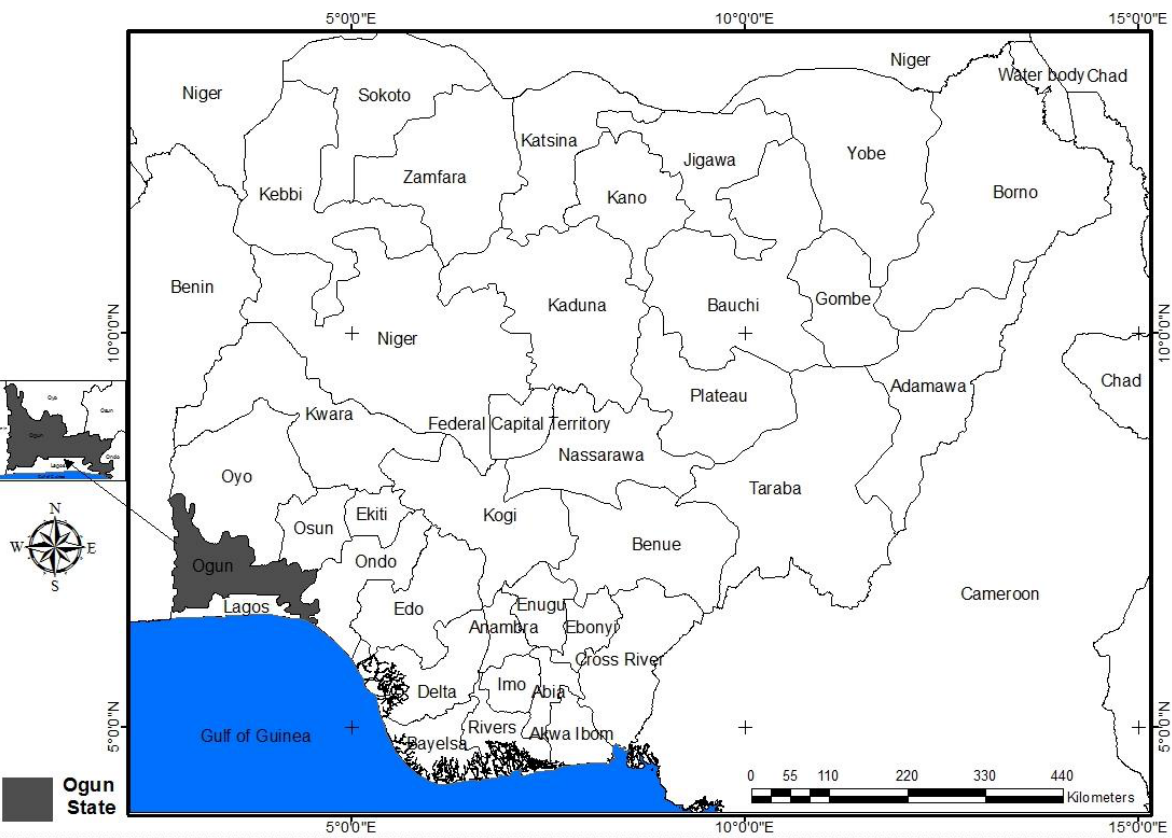
Fig. 1. Map of Nigeria showing the boundary of Ogun State, other States and neighbouring Countries (Source: Ogun State, Ministry of Land and Housing,